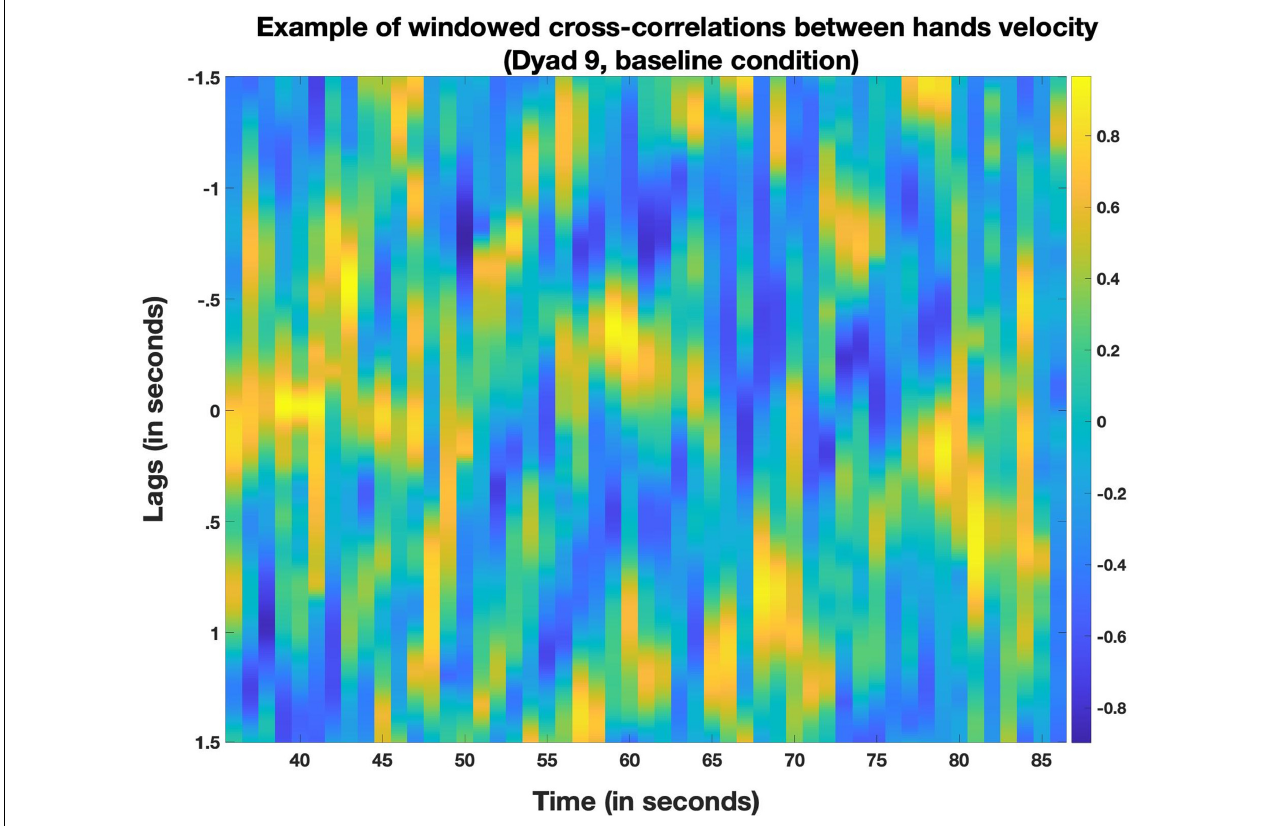
FIGURE 5 | Example of windowed cross-correlations between hands velocity of two partners (dyad 9, baseline condition). Each window is 2 s long. The one second overlap between successive windows entails the creation of a new window at every second of the velocity time series. For every window, a correlation coefficient with the partner time series was computed at every lag between 0 and 5 s, in this example in both time directions (e.g.,correlations with what the partner did up to 5 s earlier as well as later). The resulting correlogram plots the computed coefficient for every window (x axis) at every lag (y axis). The color coding indicates the strength of that correlation coefficient, with cold, most blueish colors indicating strong negative correlation and hot, most yellowish colors indicating strong positive correlations. A positive correlation along the Y-axis 0 indicates synchronous coordination. A positive correlation at negative lags (in the upper part of the plot) indicates that a subject had similar movements to what her partner did earlier (a “follower”). A positive correlation at positive lags (lower part of the plot) indicates that the subject is “leading” (the partner will later make movements that are similar to those the subject makes in the current window). In this example, we can see that both partners first synchronously coordinated (high correlations around lag 0, from 35 to 45 s approximately) before entering a phase that can be described as turn-taking with partners shifting between leading and